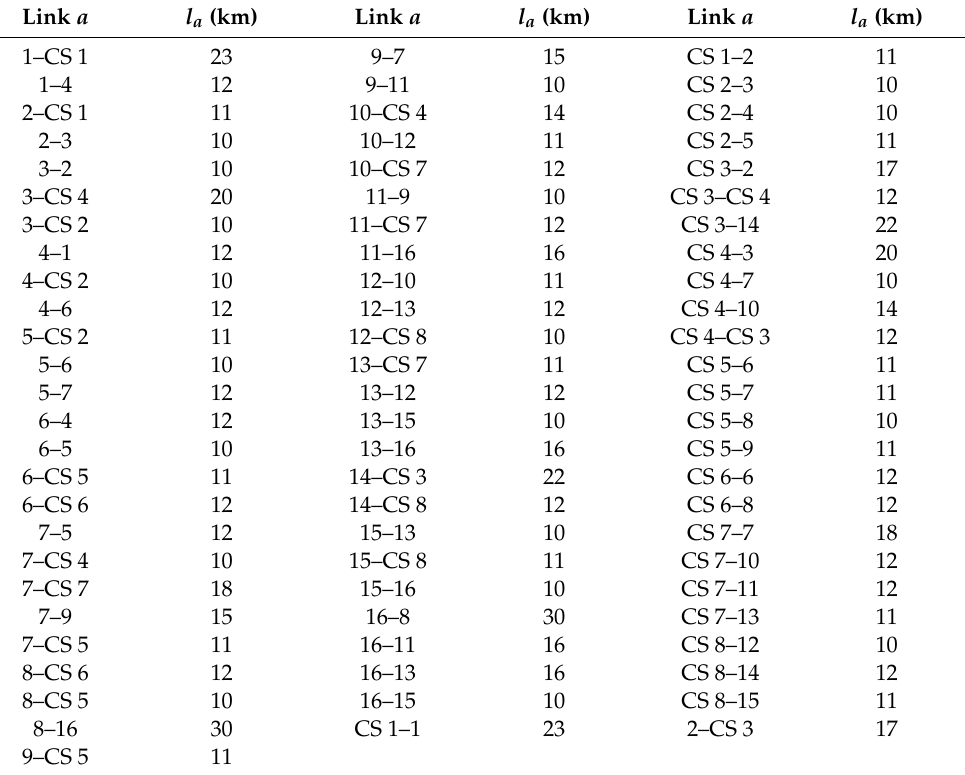
Table A5. Length l a of link a in the road